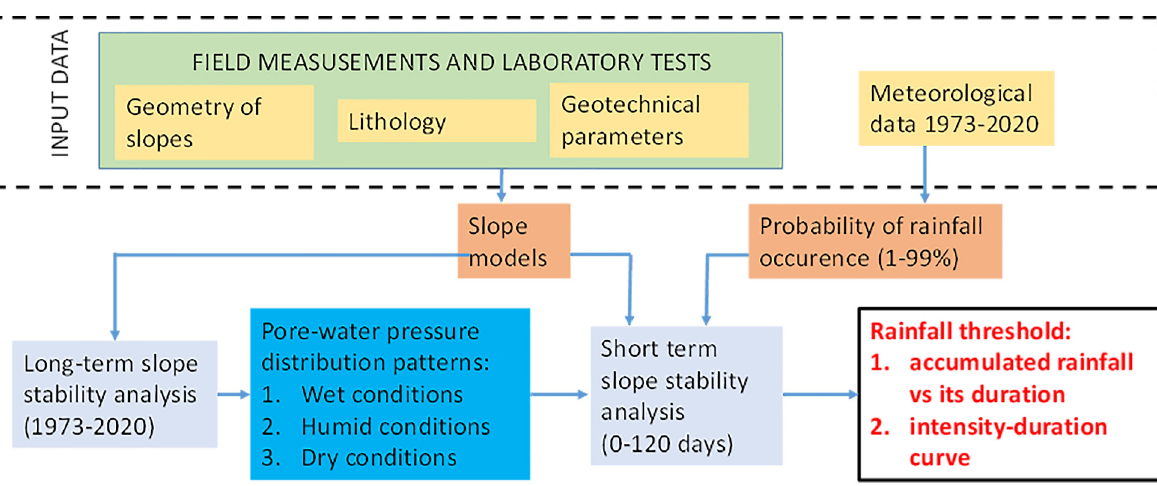
Fig. 8. Procedure for calculating the precipitation thresholds triggering landslides in the western part of the Nałęczów